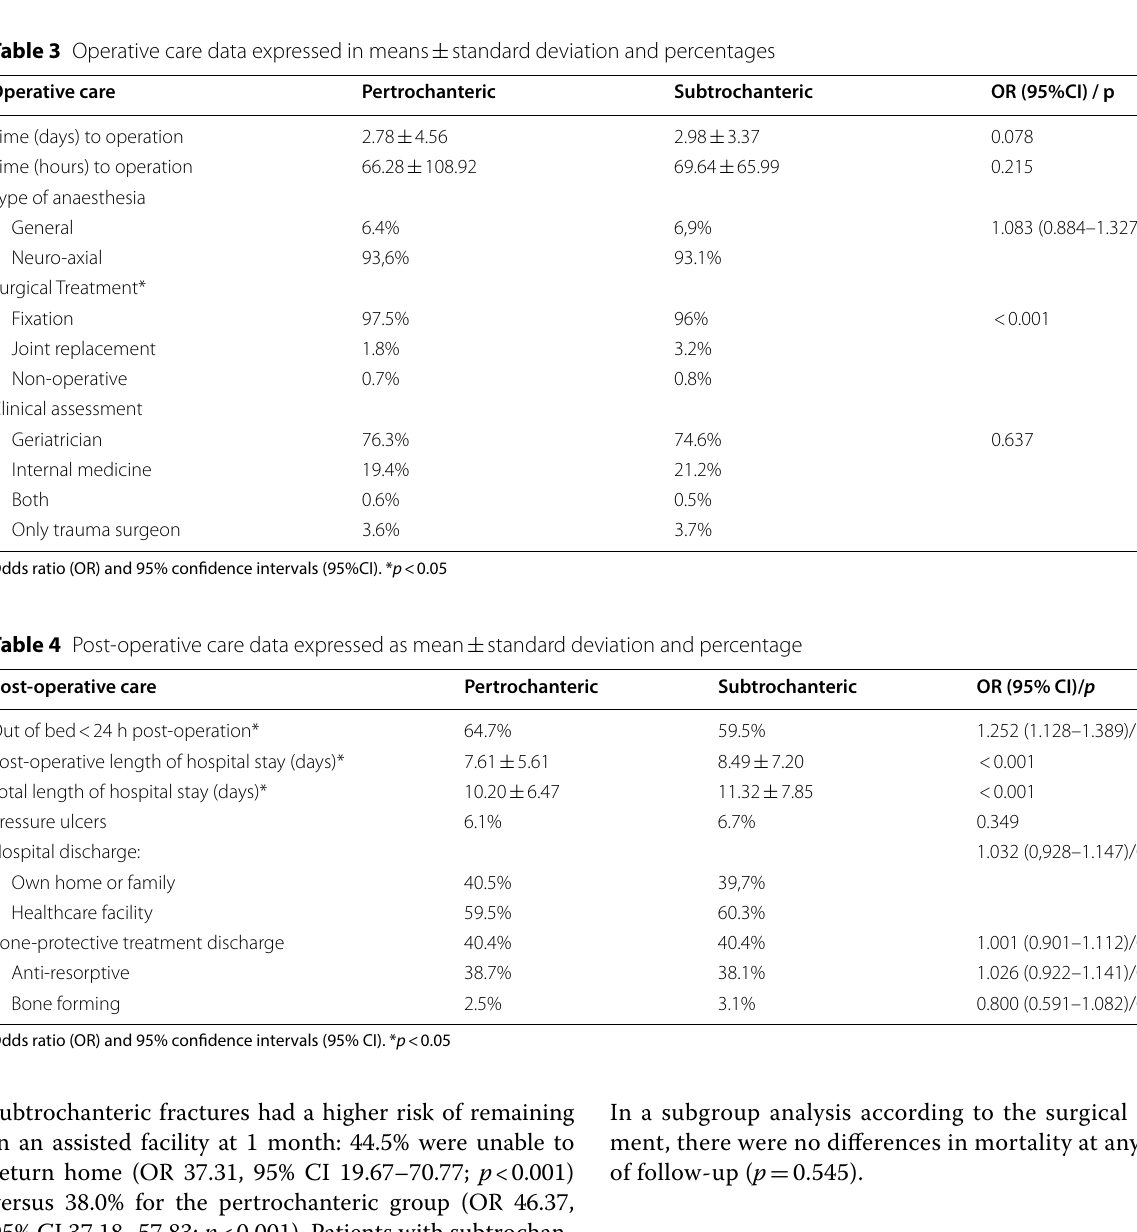
Table 3 Operative care data expressed in means